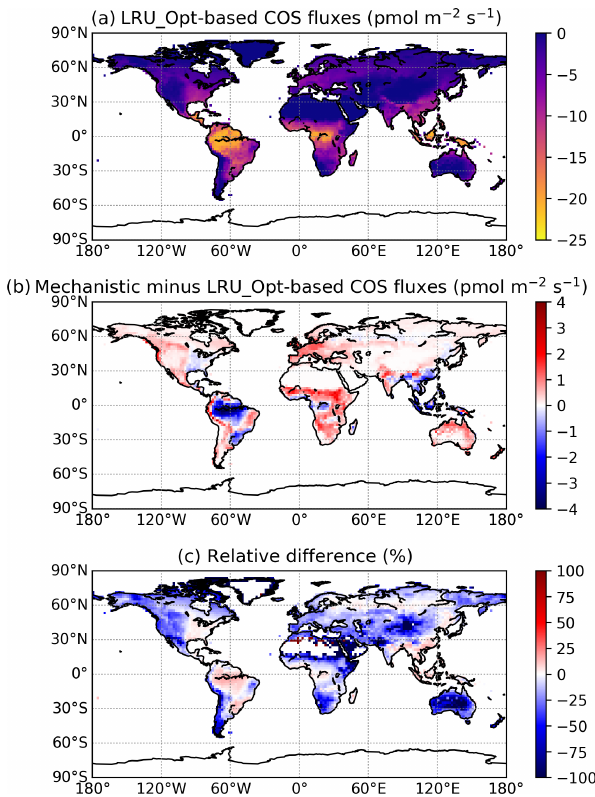
Figure 7. (a) Mean annual vegetation COS fluxes for the 2000– 2009 period fluxes computed using a linear LRU approach with op- timal values for each PFT. (b) Differences between mechanistic and LRU-based fluxes. (c) Relative difference